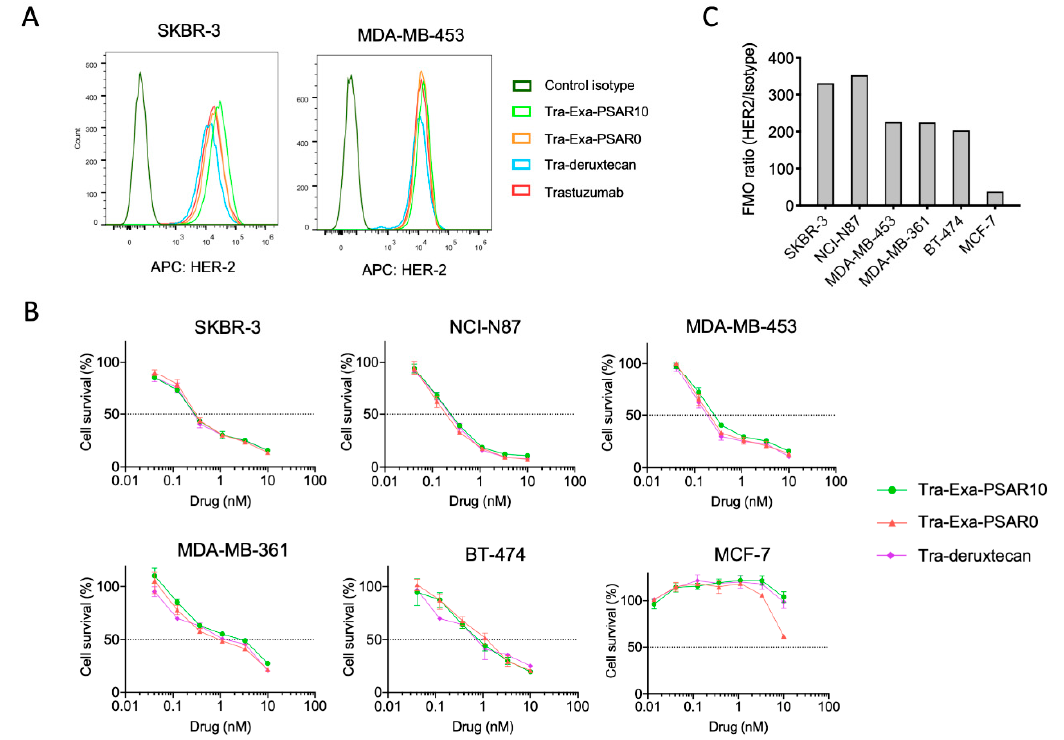
Figure 3. In vitro evaluation of Tra-Exa-PSAR10. ( A ) Trastuzumab and ADC cell binding assayed by flow cytometry. ( B ) In vitro cytotoxicity of ADCs in breast and gastric HER2+ and HER2- (MCF-7) cancer cell lines after 6-day exposure to trastuzumab conjugates, as assayed by MTT assay, n = 3. ( C ) HER2 cell surface expression in breast and gastric tumor cell lines as assayed by flow cytometry.